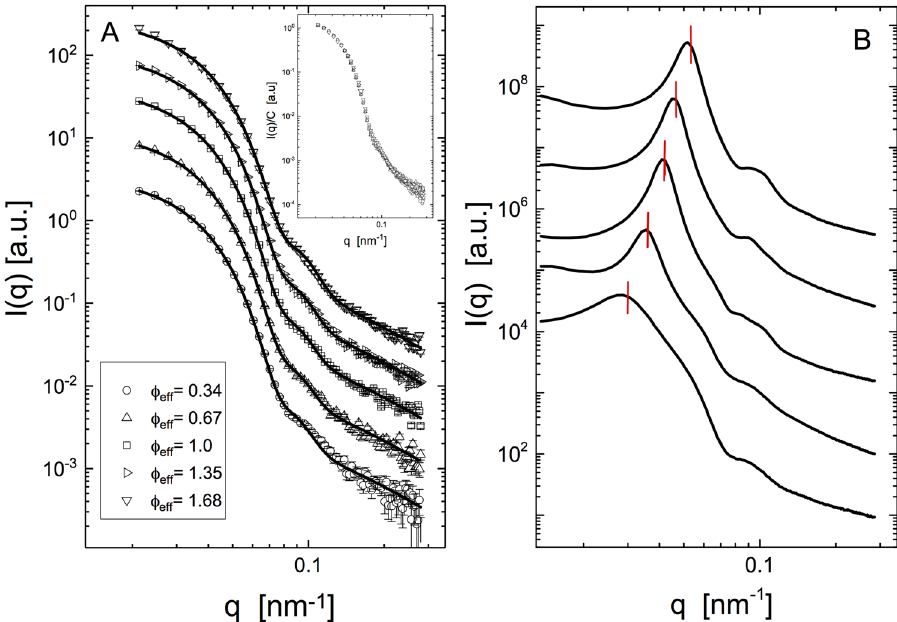
Figure 2. Small-angle neutron and X-ray scattering experiments. Shown are examples of the scattered intensity I ( q ) as a function of the scattering vector q for a 50–50 mixture of Hm and Dm particles at T = 16.4 °C in a ZAC solvent mixture for different values of the effective volume fraction 0.34 ≤ φ eff ≤ 1.68 ( A ). Note that the data are in absolute units (cm − 1 ), but the individual scattering curves are shifted in order to improve their visibility (shift factors: 1, 1.8, 4, 8 and 18 for increasing concentrations). The solid lines are the fits of the form factor for fuzzy spheres (see SI for details) to the experimental data. Also shown is the normalised scattering intensity σ ~ I q C q ( )/ ( ) d as a function of the scattering vector q for the same samples (inset), where C is the weight Ω d concentration. Examples of the scattered intensity I ( q ) as a function of the scattering vector q from SAXS experiments with a 50–50 mixture of Hm and Dm particles at T = 15 °C in a ZAC solvent mixture for different values of the effective volume fraction 0.34 ≤ φ eff ≤ 1.68, bottom to top ( B ). The position q * of the maximum of the resulting structure factor peak is also indicated. The data is offset along the ordinate for